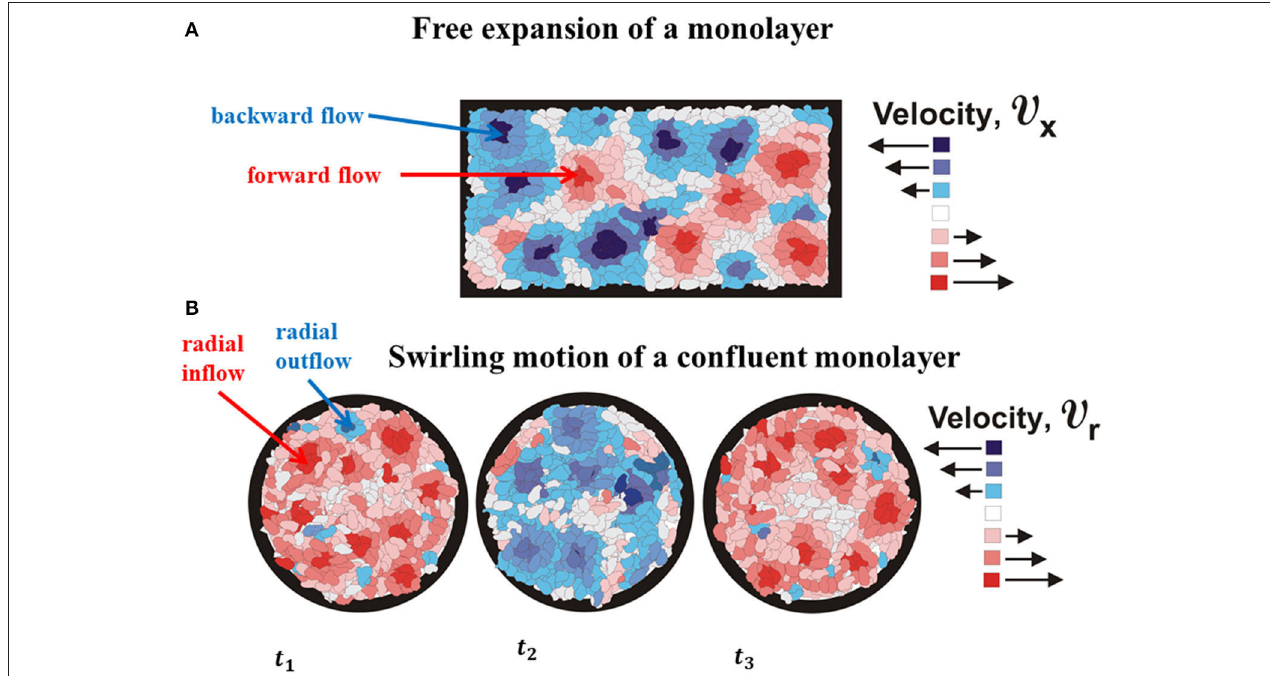
FIGURE 3 | The schematic presentation of (A) cell forward and backward flows as the characteristics of propagative waves and (B) cell outflow and inflow as the characteristics of standing waves.